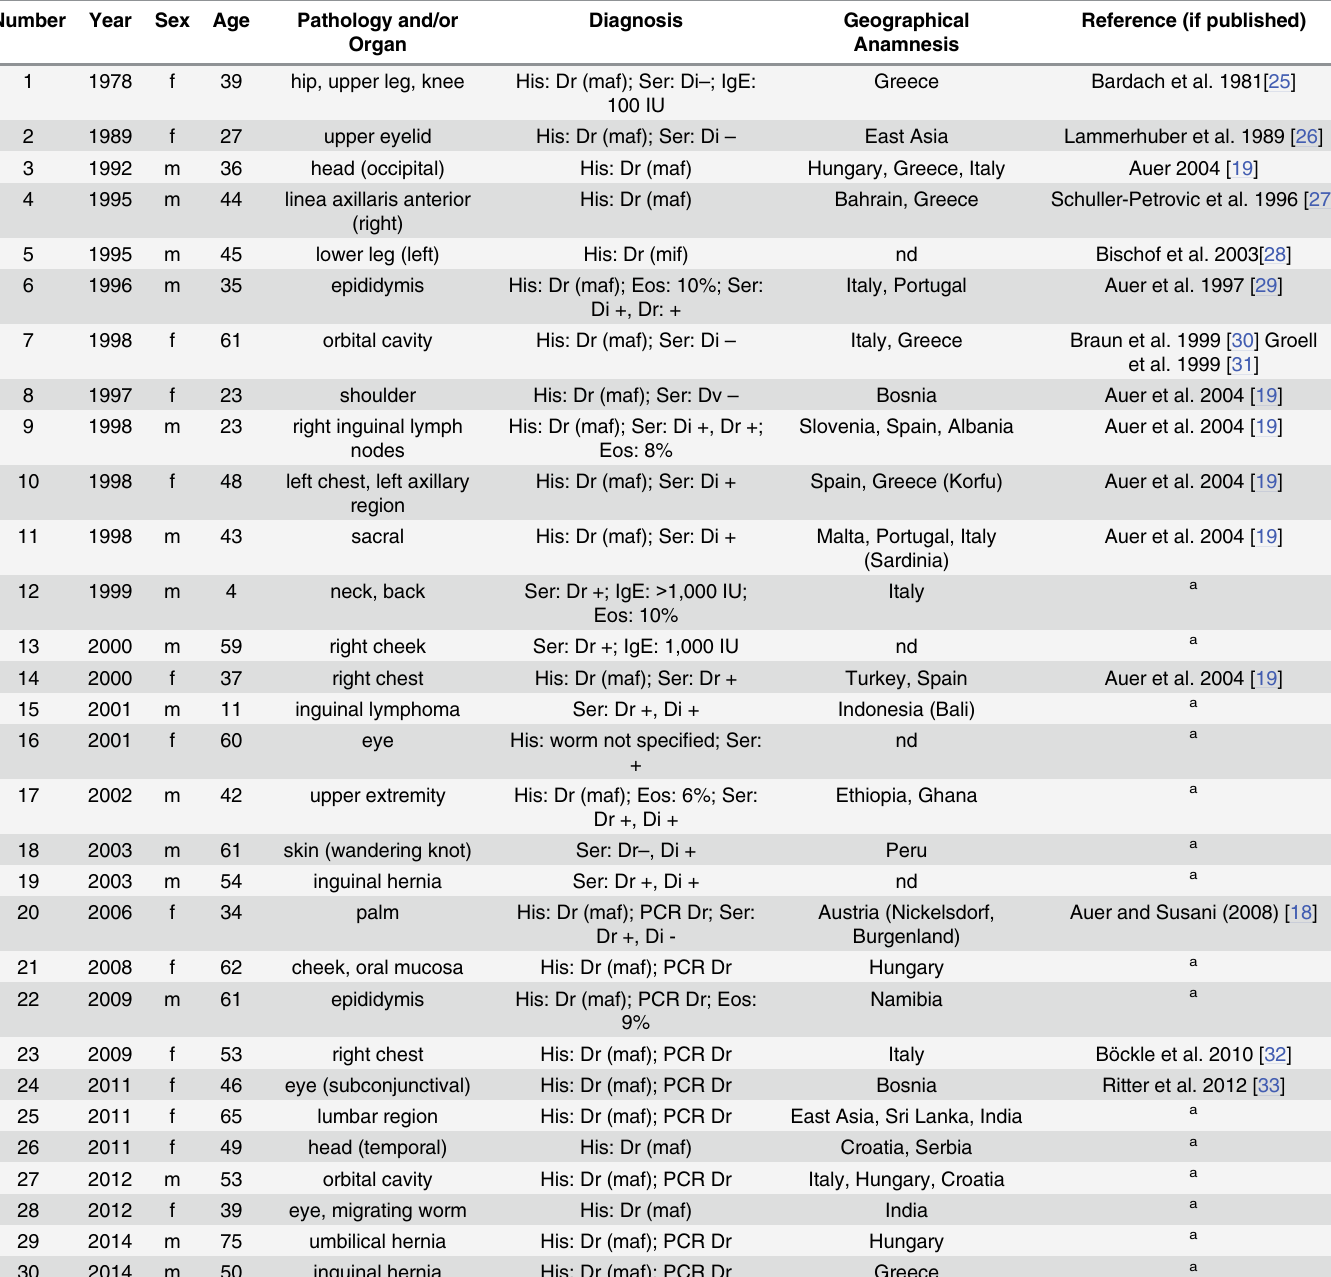
Table 2. Documented human Dirofilaria cases in Austria. Dr: Dirofilaria repens ; Di: Dirofilaria immitis ; f: female; m: male; +: positive; – : negative; nd: not determined; His: Histology; Ser: Serology; maf: microfilariae (adult stage); mif: microfilariae (first larval stage); Eos: eosinophils; IgE: immunoglobulin E; Dv: Dipetalonema viteae